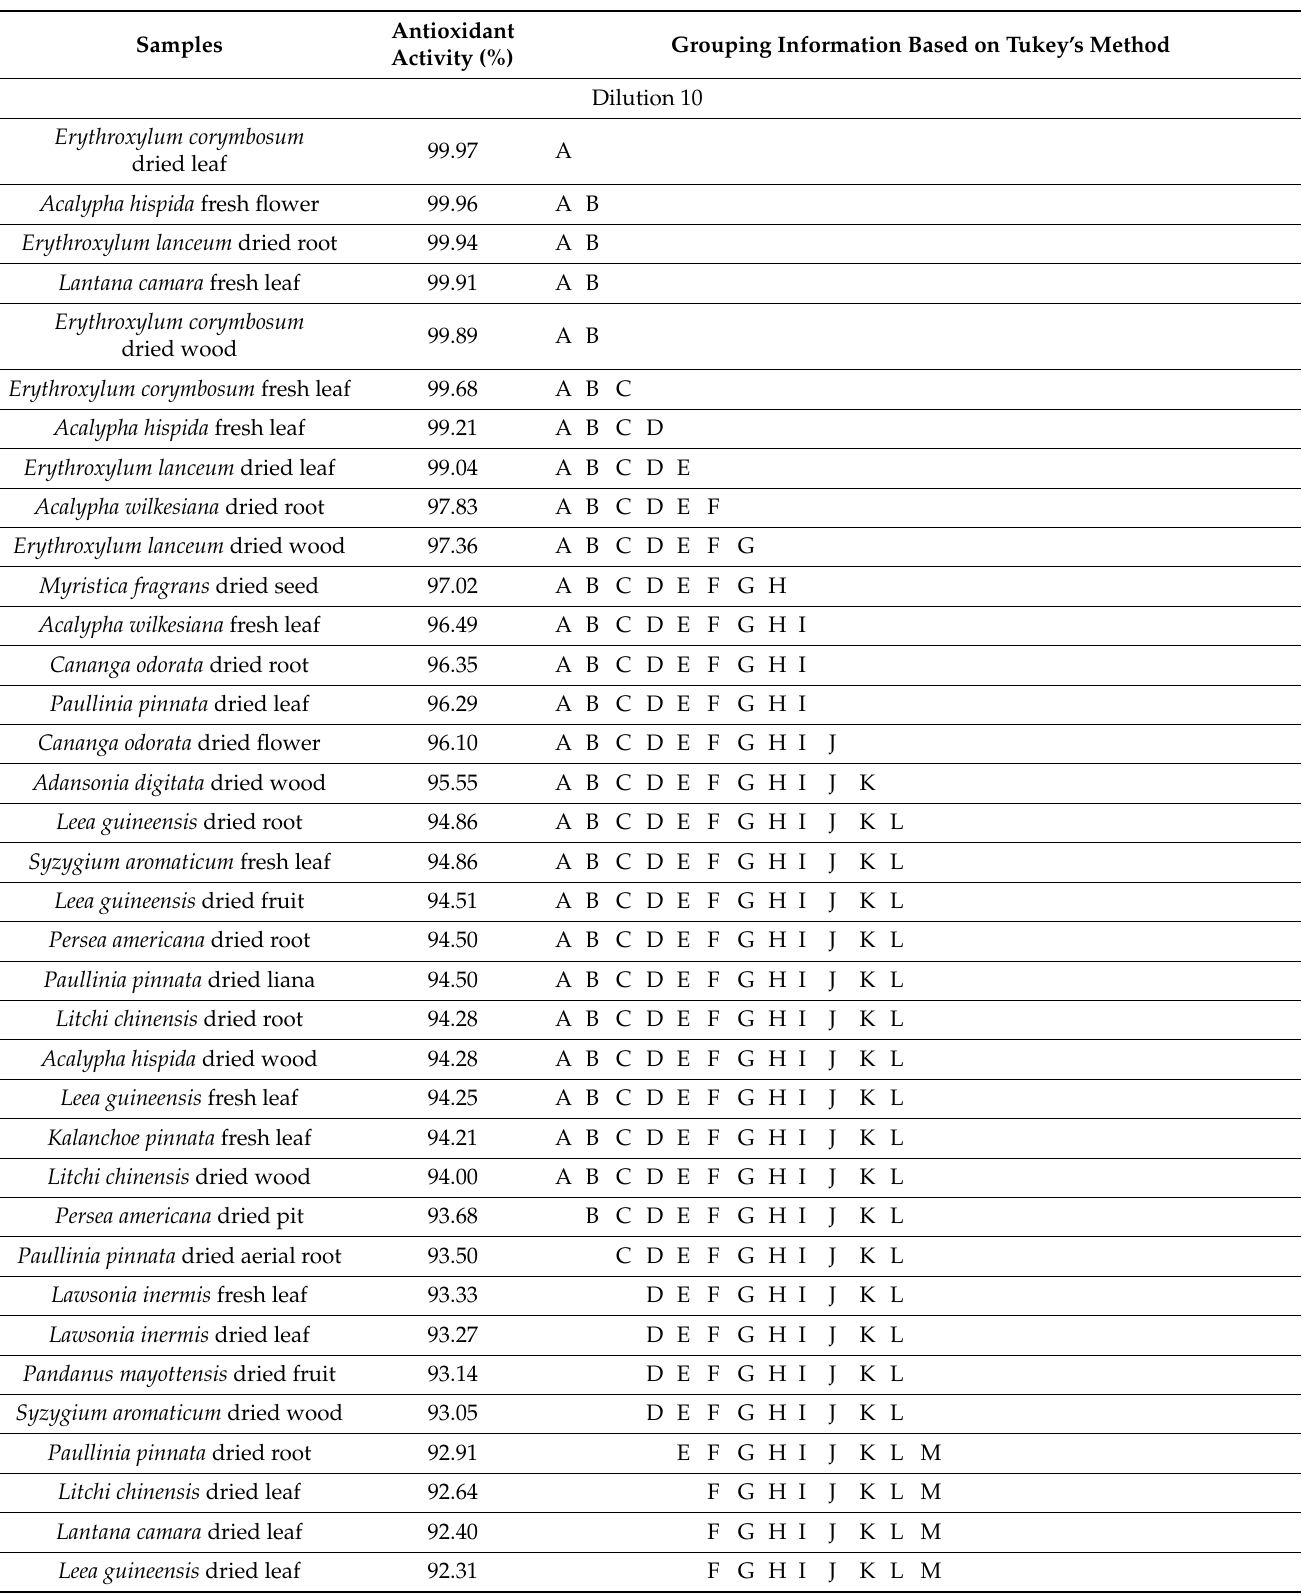
Table 3. Antioxidant activity results (DPPH assay) for the plant extracts diluted 10, 100 and 1000 times ( n = 3). Results were statistically analyzed using Tukey’s grouping test (confidence level: 95%), and the observed group classifications (A, B, C . . . . . . etc.) are shown in the present